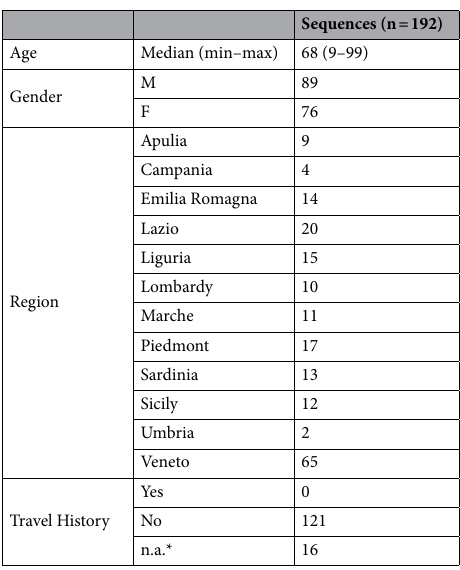
Table 1. Characteristics of the studied populations. *n.a.: not available.